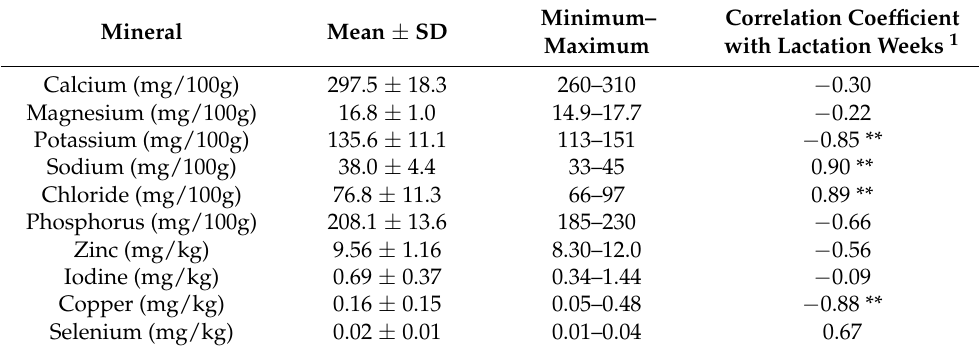
Table 1. Mineral composition of deer milk and its variation over the lactation.